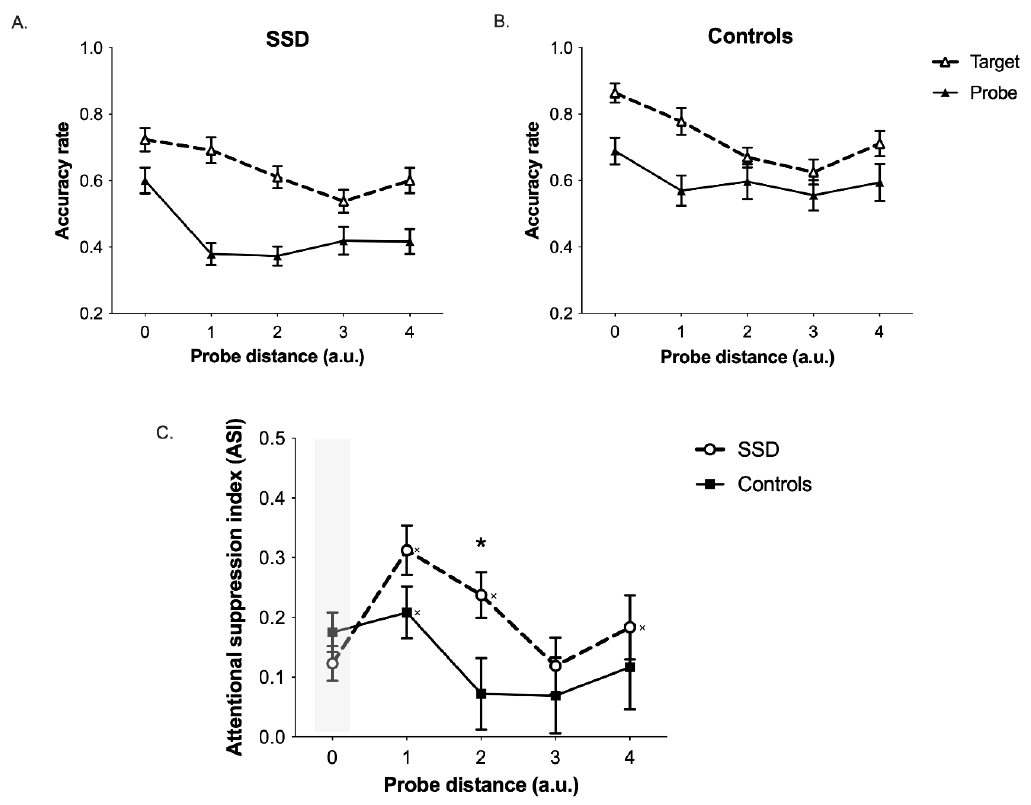
Figure 2. Results showing the spatial profile of the attentional focus in SSD. ( A , B ) Plots showing mean accuracies in the ( A ) SSD and ( B ) control group as a function of task condition and probe distances (PD) (PD0 = center of the attentional focus. PD1 – PD4 = positions progressively farther from the center of the focus). Chance level = 0.25. ( C ) Attentional suppression index (ASI), computed as the accuracy difference between the probe and the target conditions, as a function of group (SSD and controls) and PD. The shaded area represents data points not considered for planned comparisons. * = p < 0.05 for independent samples t -tests (SSD vs. controls); × = p < 0.05 for within-samples t -tests against 0. Bars represent the SEM.